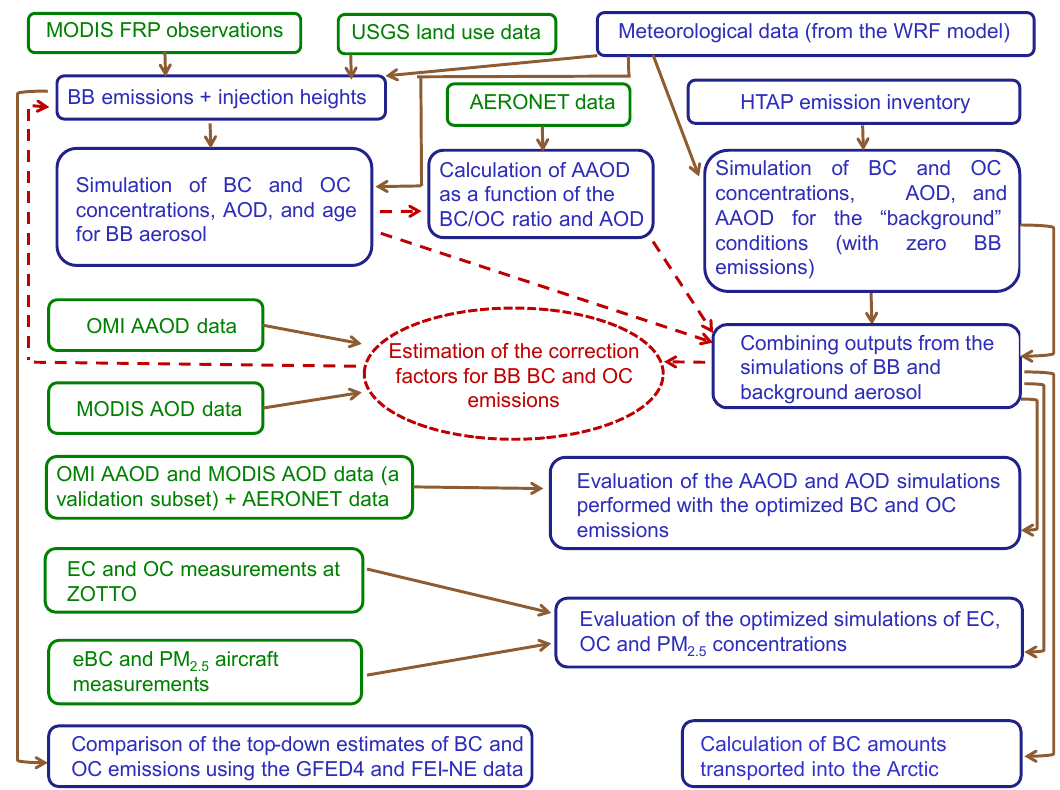
Figure 1. Schematic representation of the study design. Green is used to depict the observational data used in the analysis. Red and dotted red lines illustrate the iterative procedure aimed at the optimization of the BB BC and OC